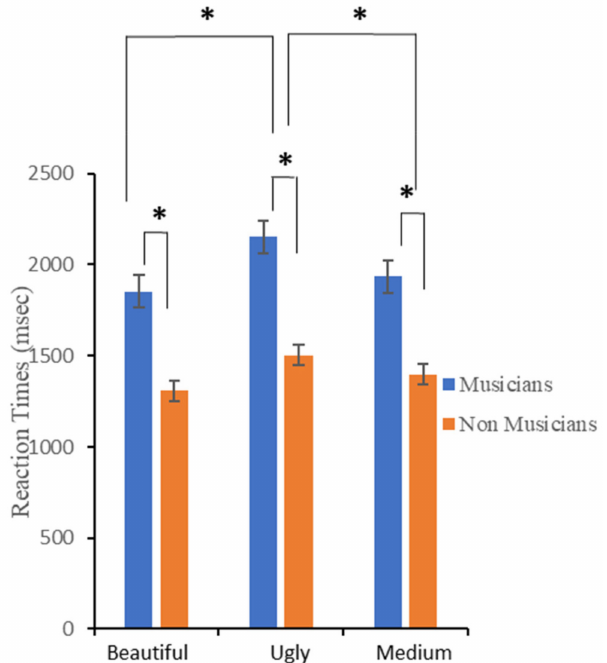
Figure 5. Participants’ mean reaction times (ms) for the emotional evaluation. Error bars represent ± 1 SEM. Asterisks represent significant